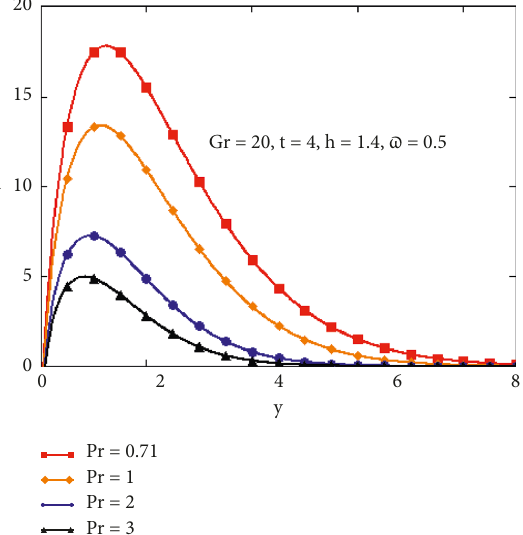
Figure 3: Velocity profile for different values of Pr.